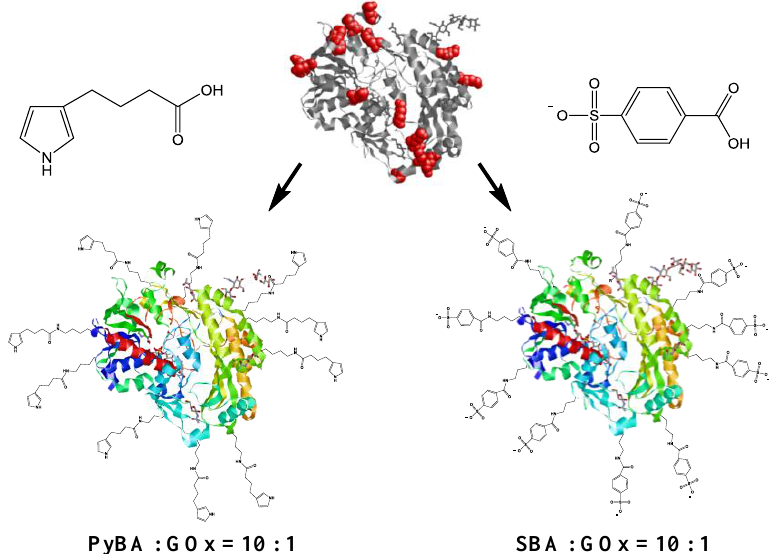
Figure 3. Subunit of glucose oxidase from Aspergillus niger with Lysine groups in red ( top ), monomerized enzymes used for preparing P(Py- co -PyBA- con -Gox) ( bottom left ) and sulfonated ( bottom right ) enzymes used for preparing PPy(SBA- con -GOx) with 10:1 ratio of PyBA or SBA conjugation to